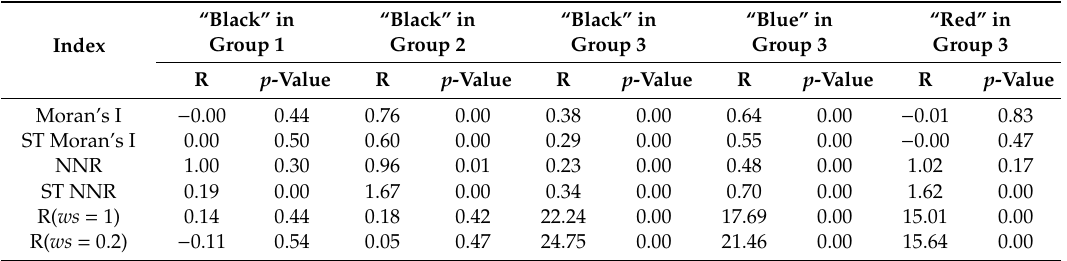
Table 1. Results in three group data (the ST in the table denotes